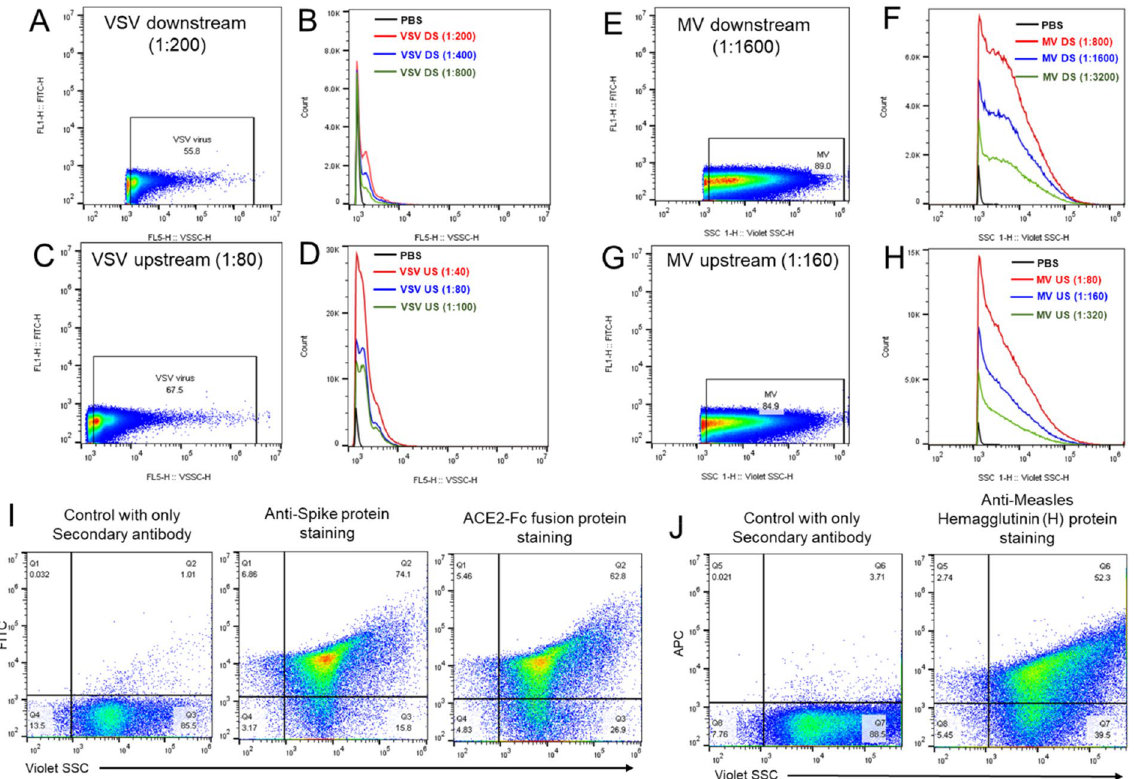
Figure 5. Violet laser side scattering (VSSC) profiles and antibody staining confirmed detection of individual virus particles by flow virometry for C1 and C2 vaccine candidates. ( A ) Dot plot of a representative C1 vaccine downstream drug substance was analyzed by CytoFLEX. C1 viral particles were detected as a monodisperse population that could be resolved by VSSC alone. Gating strategy was set based on VSSC of PBS background. Numbers in the gate indicated the percentage of particles in total events. ( B ) CytoFLEX histogram overlays of PBS background and C1 vaccine downstream drug substance in 0.1 µm filtered PBS buffer at a dilution of 1:200, 1:400, and 1:800. Single peaks from C1 viral particles were detected at optimal dilutions for the purified downstream sample. ( C ) Dot plot of a representative C1 vaccine upstream sample harvested from bioreactors was analyzed by CytoFLEX. ( D ) CytoFLEX histogram overlays of C1 vaccine upstream harvest sample in 0.1 µm filtered PBS buffer at a dilution of 1:40, 1:80, and 1:100. Peaks with right shoulders were observed at optimal dilutions for bioreactor samples, suggesting the cellular components or impurities available in upstream samples. ( E ) Dot plot of a representative C2 virus vaccine downstream drug substance was analyzed by CytoFLEX. Widely distributed populations were detected for C2 virus. Gating strategy was set based on VSSC of PBS background. Numbers in the gate indicated the percentage of particles in total events. ( F ) CytoFLEX histogram overlays of C2 vaccine downstream drug substance in 0.1 µm filtered PBS buffer at a dilution of 1:800, 1:1600, and 1:3200. Broad peaks were detected at optimal dilutions for the purified downstream sample. ( G ) Dot plot of a representative C2 vaccine upstream sample harvested from bioreactors was analyzed by CytoFLEX. ( H ) CytoFLEX histogram overlays of C2 vaccine upstream harvest sample in 0.1 µm filtered PBS buffer at a dilution of 1:80, 1:160, and 1:320. ( I ) Representative plots of C1 vaccine stained with anti-Target protein antibody or cellular receptor fusion protein antibody followed by a secondary antibody conjugated with AF488 fluorescence. Violet laser side scattering (VSSC) defines virus population on X-axis, while FITC fluorescent signal on Y-axis indicates membrane staining with anti-virus target protein antibody or cellular receptor fusion protein antibody. Gating strategy was set based on viral particles stained without primary antibodies but with only secondary antibody conjugated with AF488. The upper right quadrant (Q2) of each plot represents virus surface protein- positive virus particles. ( J ) . Representative plots of C2 vaccine stained with anti-C2 surface protein antibody followed by a secondary antibody conjugated with AF647 fluorescence. Violet laser side scattering (VSSC) defines virus population on X-axis, while APC fluorescent signal on Y-axis indicates membrane staining with anti-Measles H protein antibody. Gating strategy was set based on Measles virus stained without the primary antibody but with only secondary antibody conjugated with AF647. The upper right quadrant (Q2) of each plot represents C2 surface protein-positive virus